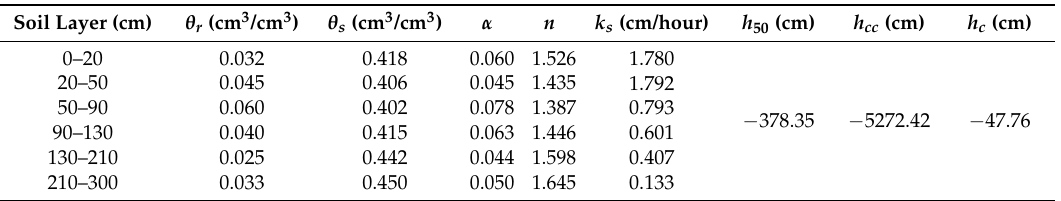
Table 3. The results of the model parameter